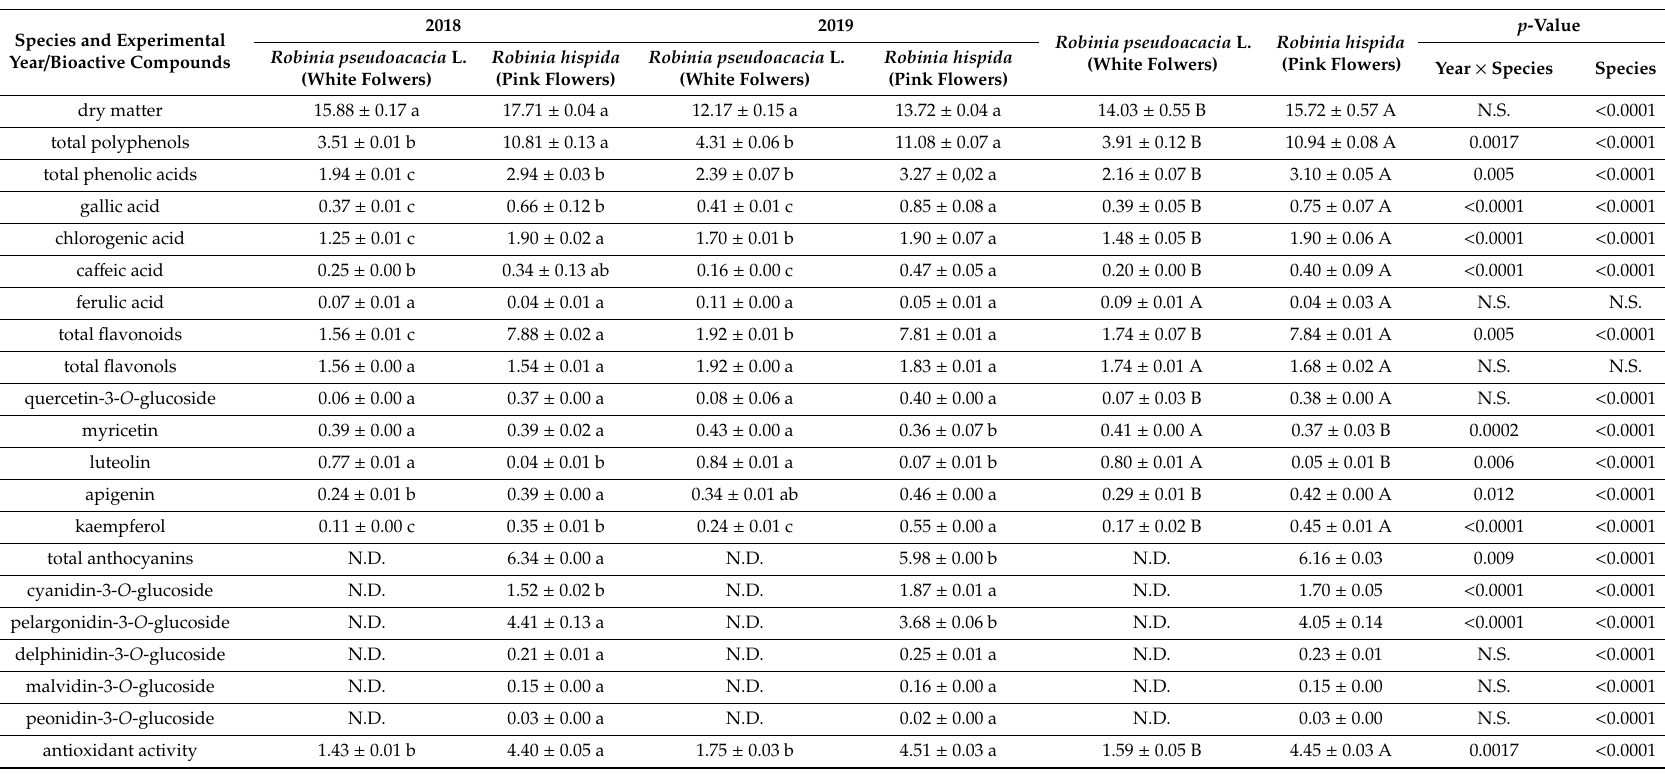
Table 1. Concentration of dry matter (in g / 100 g FW), phenolic compounds (in mg / g FW), and antioxidant activity (in mM / g FW) in examined Robinia flowers in two years of experiment